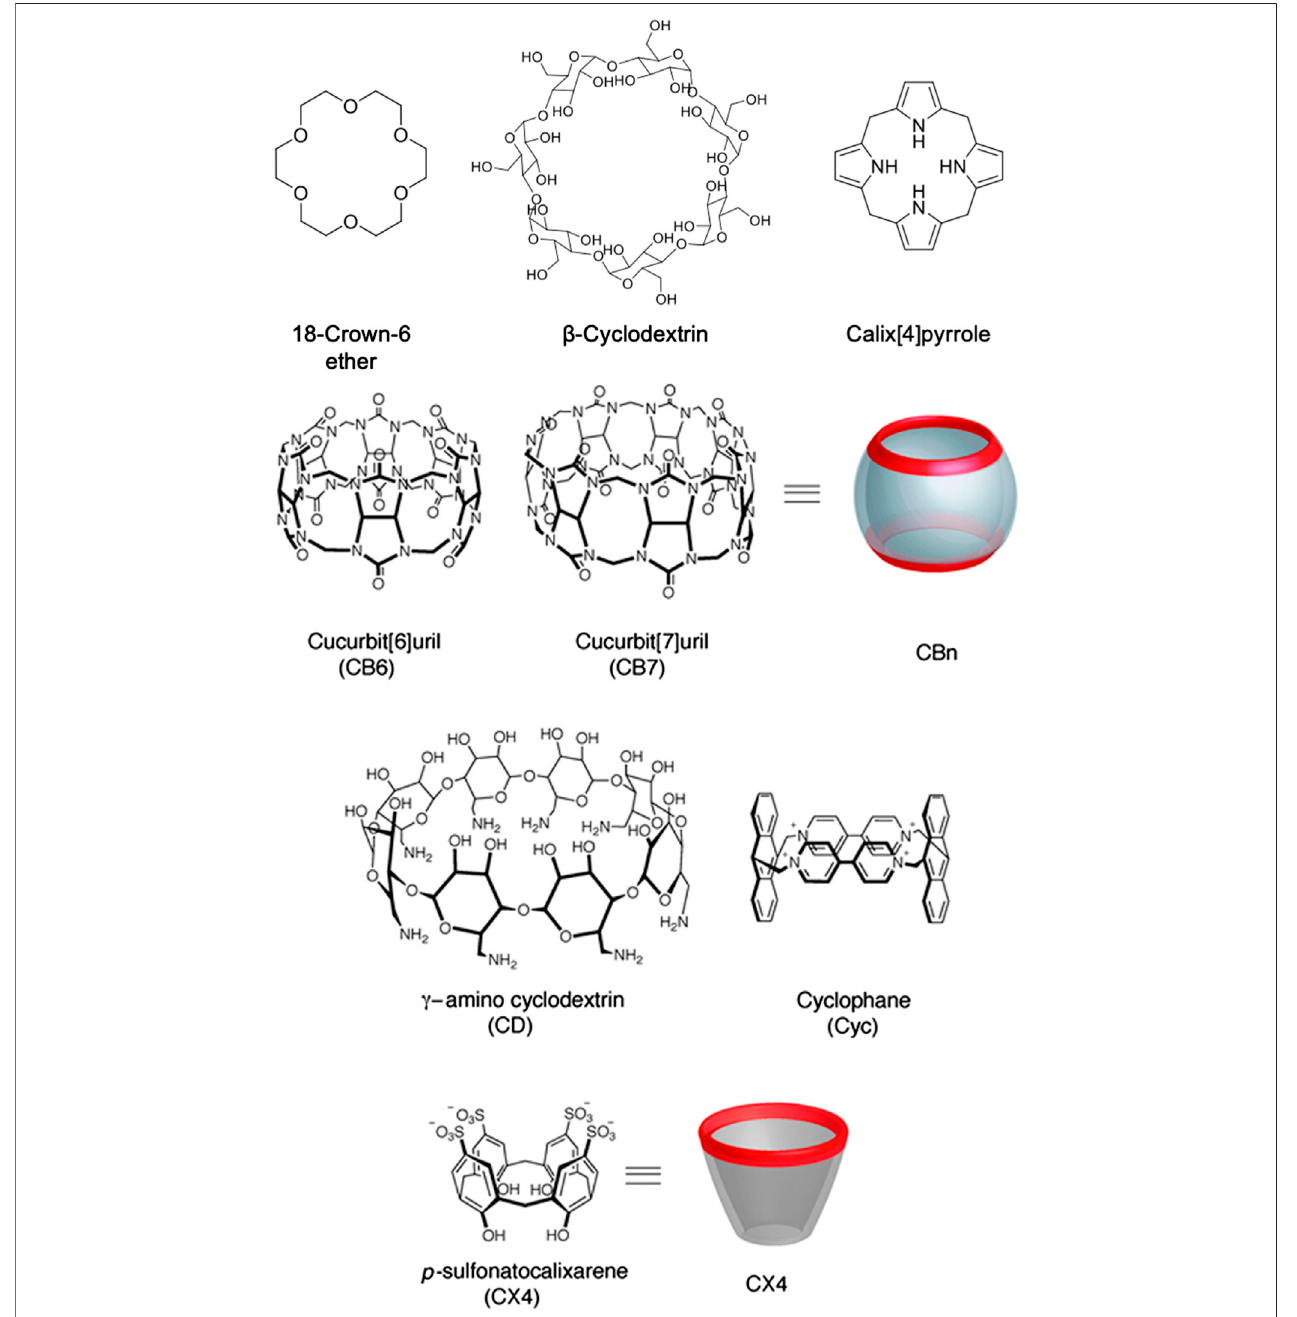
FIGURE 3 | Examples of macrocycles used as supramolecular recognition units for biosensing. Adapted from Ghale et al., 2014. Copyright 2014 American Chemical Society.